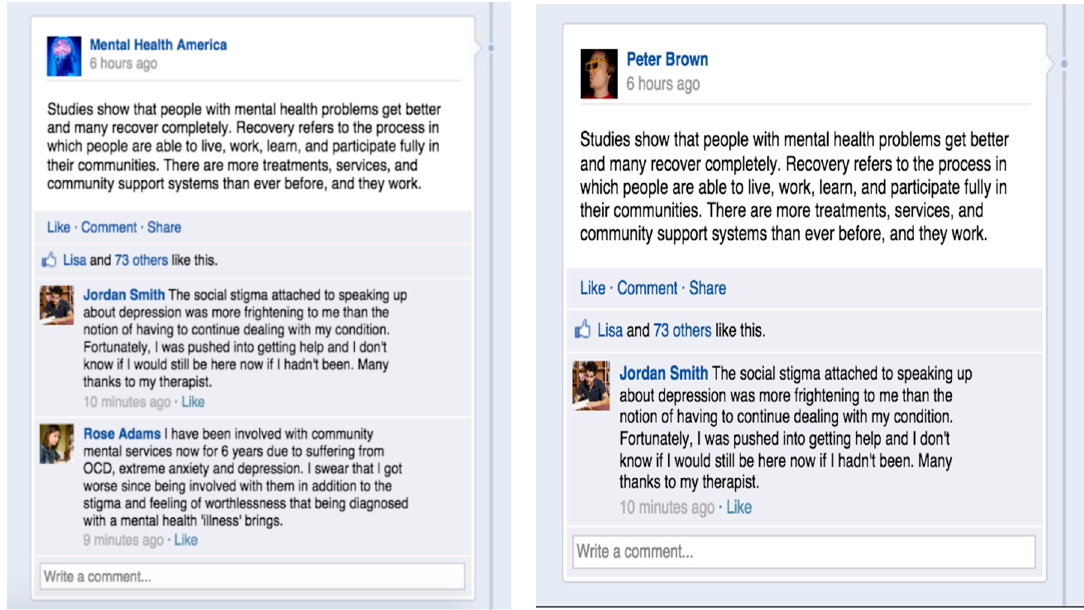
Figure 3. Professional Source 2 and Mixed Comments 2 vs. Layperson Source 2 a and Positive Comments 2 b . a Layperson source 2 and professional source 2 have the same content except